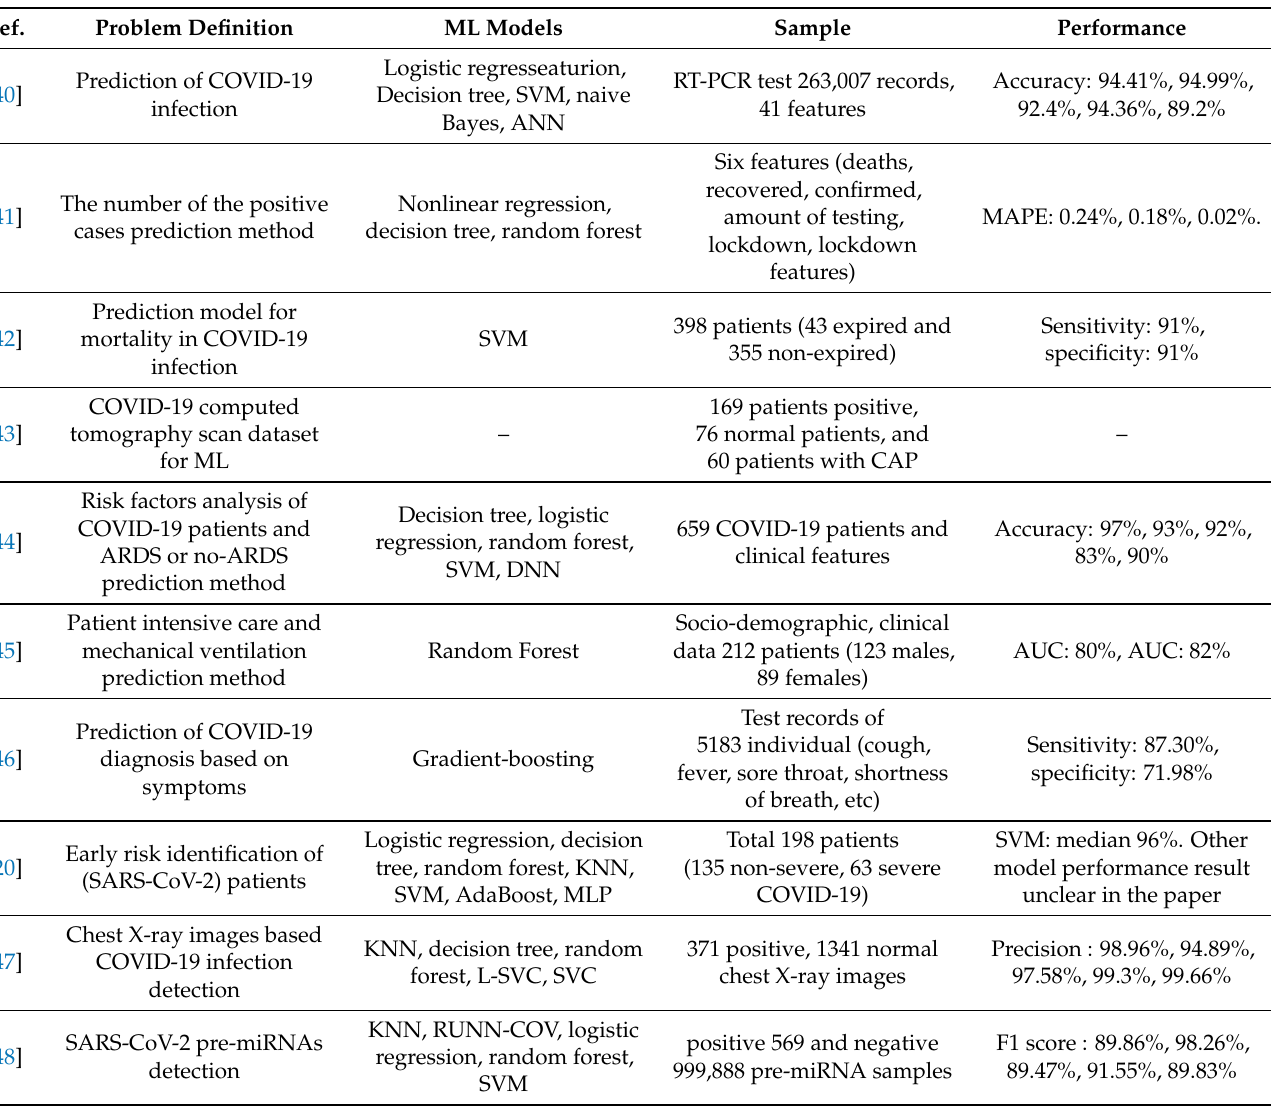
Table 1. The systematic overview of problems and solutions addressed through the supervised learning methods for